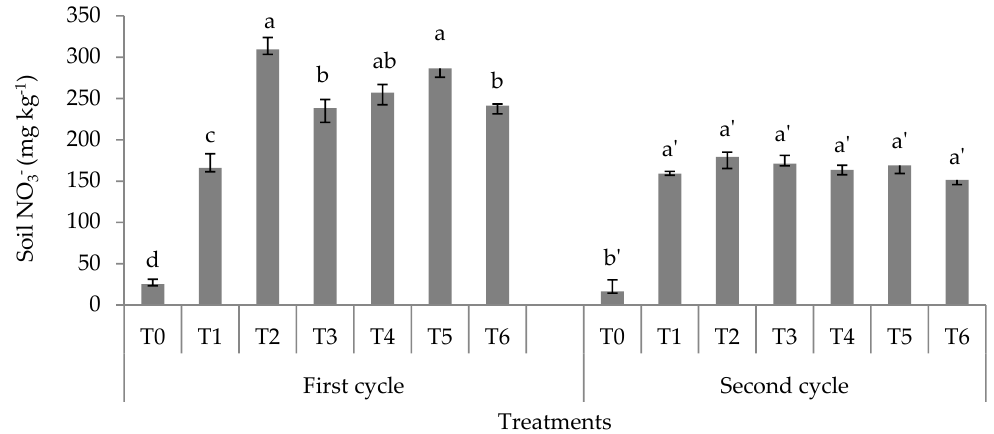
Figure 9. Effects of treatments on soil available nitrate. Means with the same letter above the bars within a crop cycle are not significantly different at p ≤ 0.05. Bars represent the mean values ± standard error .